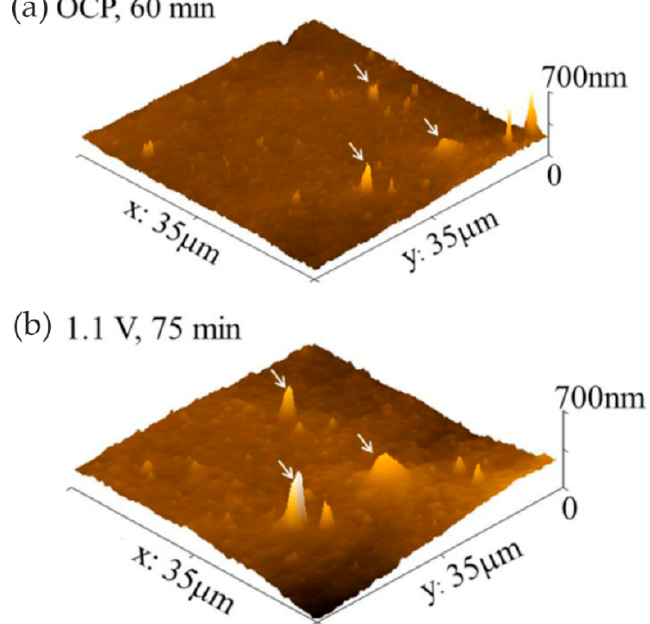
Figure 30. EC-AFM images (3D) of the same area of the composite coating obtained after 14 h of exposure in 3.0 wt% NaCl solution: ( a ) after 60 min at OCP; ( b ) after 75 min at 1.1 V vs. Ag/AgCl. Adapted with permission from Reference [68]; copyright 2015 Electrochemical Society.